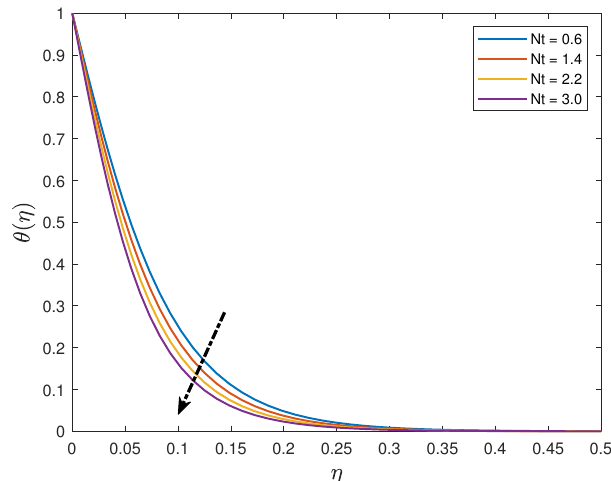
Figure 11. Influence of Nt on the nanofluid